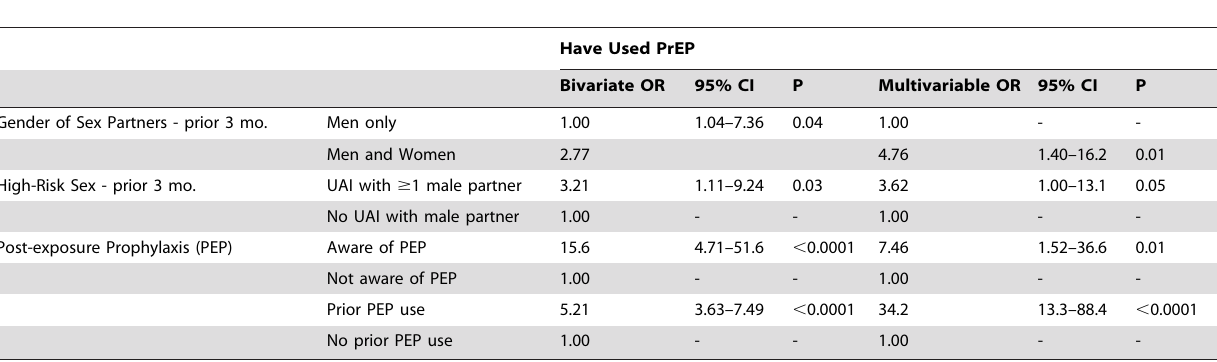
Table 5. Participant Characteristics associated with Prior Use of Pre-Exposure Prophylaxis (n=29) One Month after Publication of Efficacy Results (the iPrEx Study).